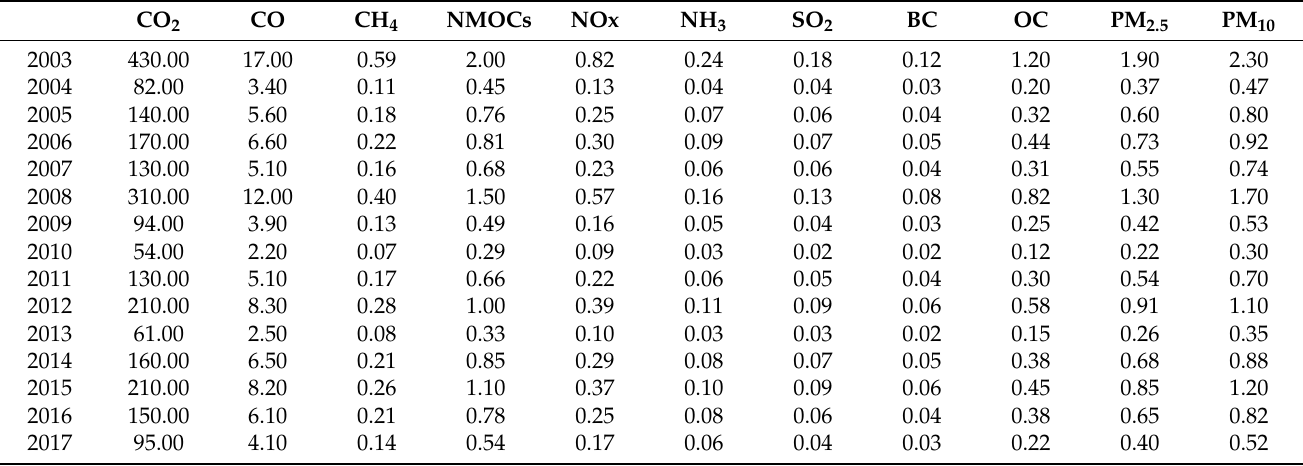
Table 3. Annual biomass burning emissions for each species (Unit: